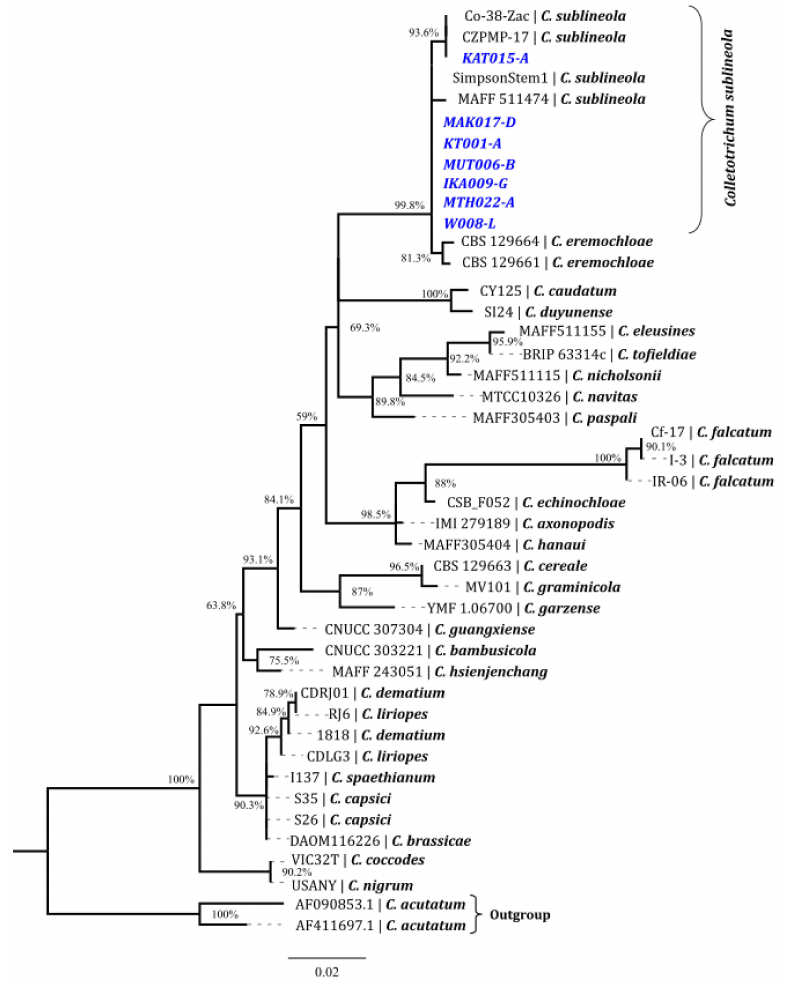
Figure 2. Phylogenetic analysis of Colletotrichum sublineola constructed with the sequences for ITS regions. Phylogenetic relationships were inferred using the neighbor-joining method. The values at the nodes represent bootstrap proportions from 1000 bootstraps. The evolutionary distances were calculated using Kimura-2-parametre with different gamma shape parameters for each tree. All the positions containing gaps were deleted. The tree was rooted to the two members of Colletotrichum acutatum and was drawn to